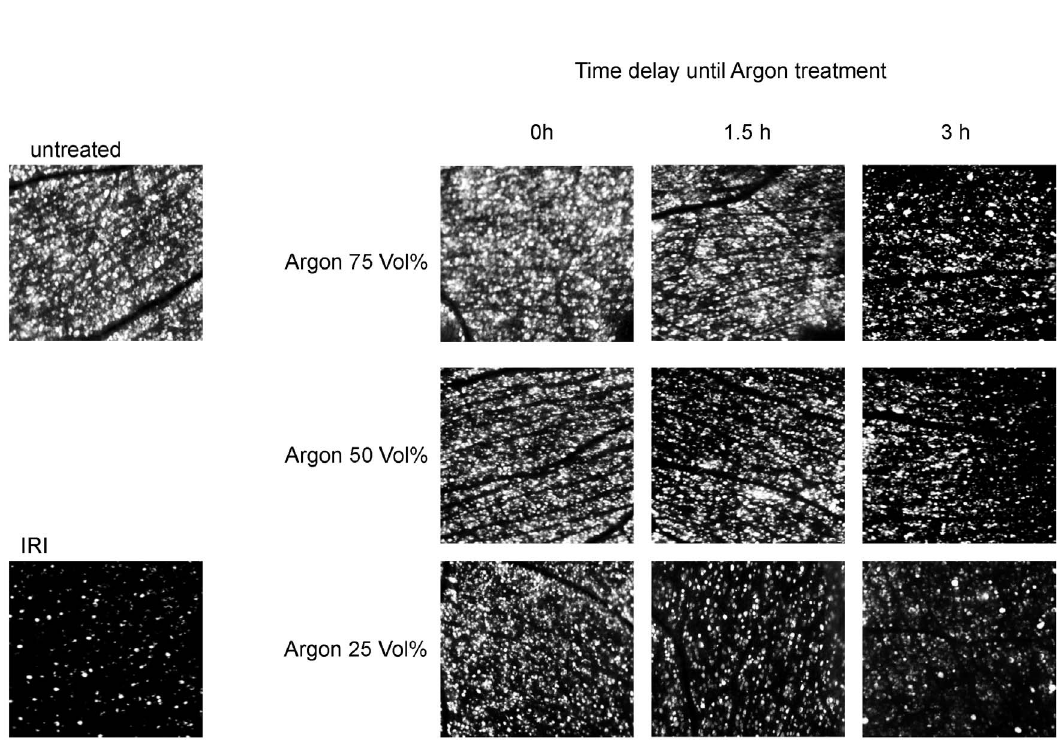
Fig. 2. Time- and dose-dependent influence of Argon inhalation on vital retinal ganglion cells after ischemia reperfusion injury (IRI). Representative flat mount images (n 5 8) of fluorogold labeled retinal ganglion cells 7 days after IRI and immediate and delayed (i.e. 1,5 and 3 hours delay) Argon inhalation (25, 50 and 75 Vol%).